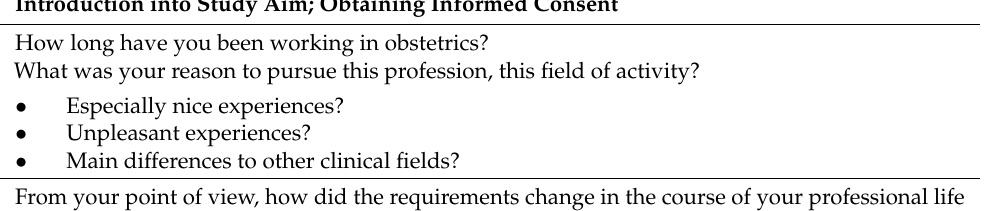
Table 1. Semi-structured interview